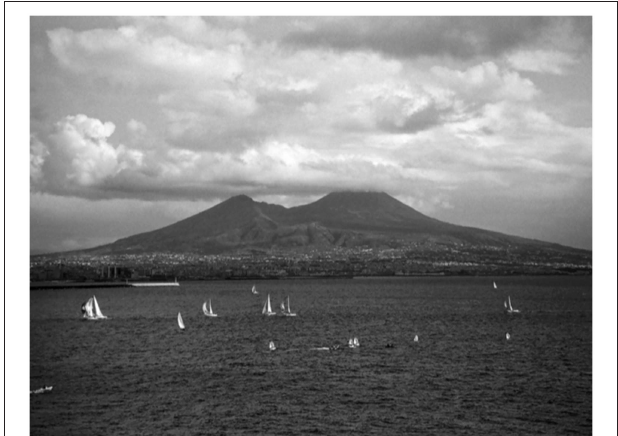
FIGURE 1 | Naples, where Professor Serafino Zappacosta founded the Scuola Superiore d’Immunologia Ruggero Ceppellini in 1991. Image: Vera Maone, used with